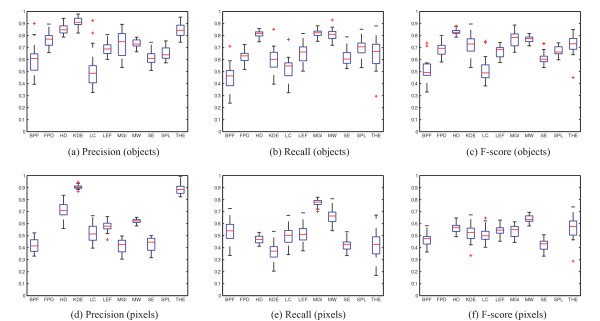
Precision, recall, and F-score are calculated using computer-generated ground truth as reference at object level (a-c) and pixel level (d-f). Note that the two algorithms (FPD and SPL) are omitted from pixel-level comparison in d-f.